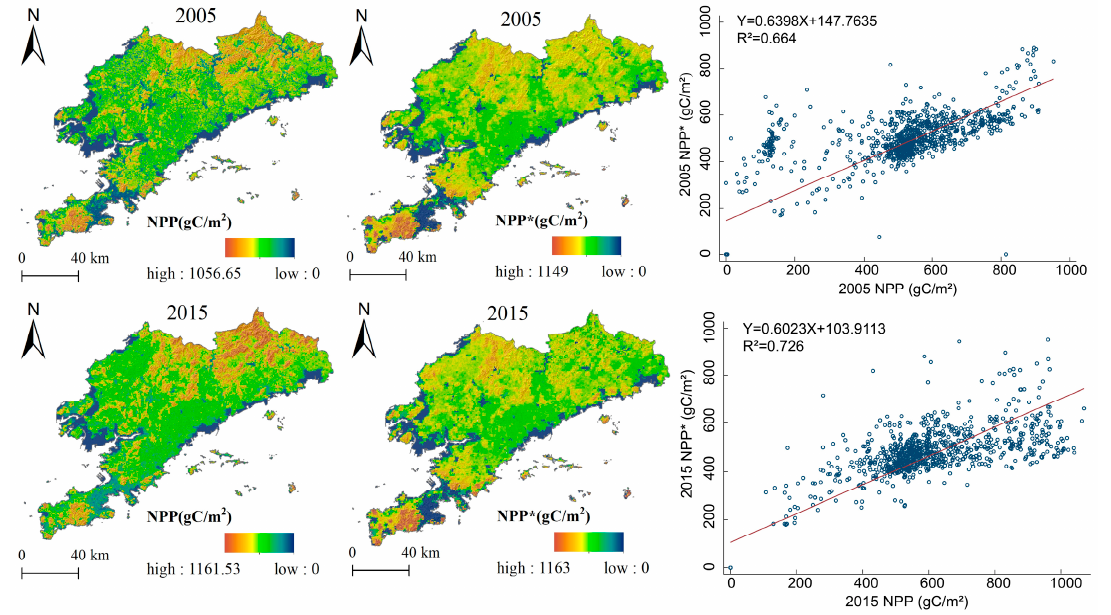
Figure 8. Comparison between NPP and NPP*; X: independent variable NPP; Y: dependent variable NPP*; R 2 : coefficient of determination. R 2 between 0–1. the closer to 1, the better the regression fitting effect.